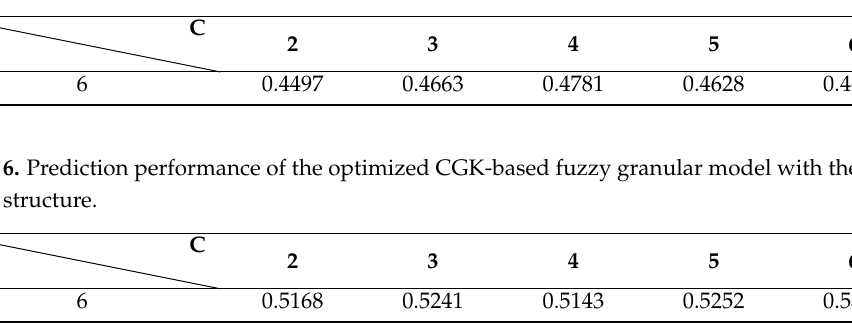
Figure 12. Performance index of the CGK-based fuzzy granular model of the aggregated structure for testing data (uniform generation of contexts, number of contexts = 6, number of clusters = 4).